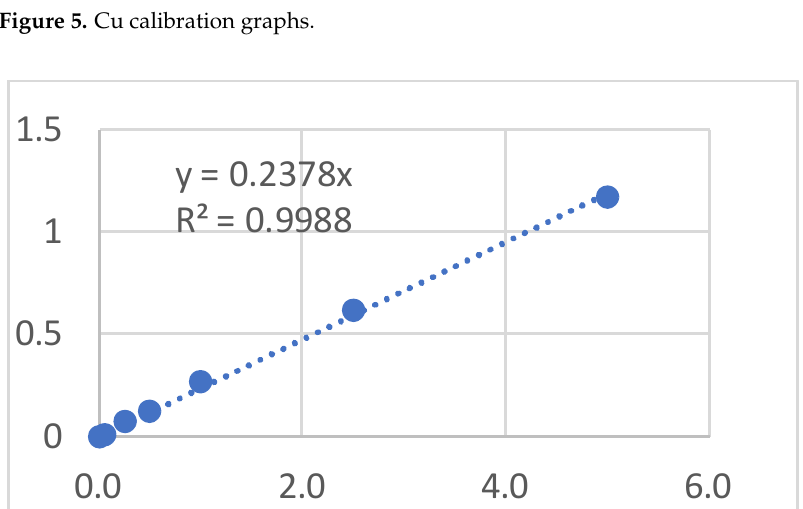
Figure 5. Cu calibration graphs